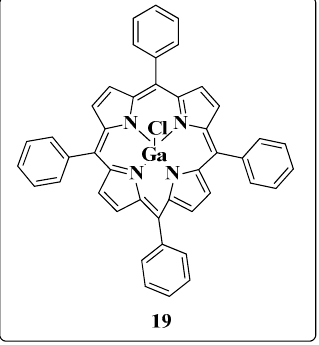
Figure 17. Anti-HIV and anti-MTB activities of borrelidin reported by Bhikshapathi et al. in 2010 [95].